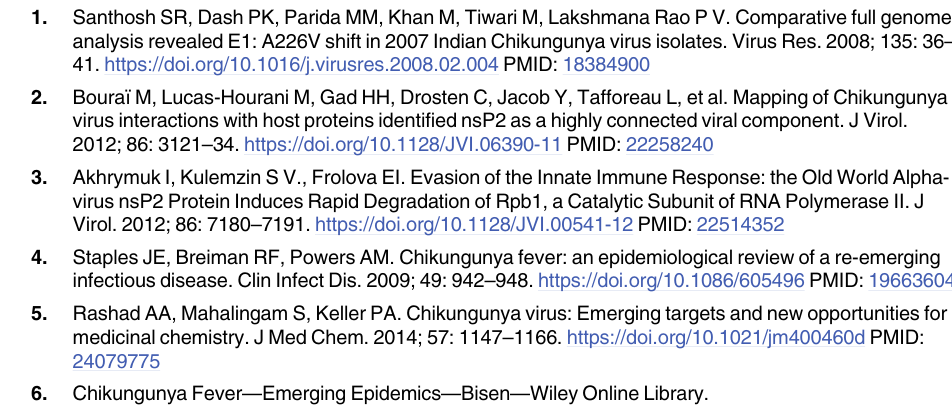
S1 Table. Primer and probe sequences. S2 Table. Statistical analysis of the